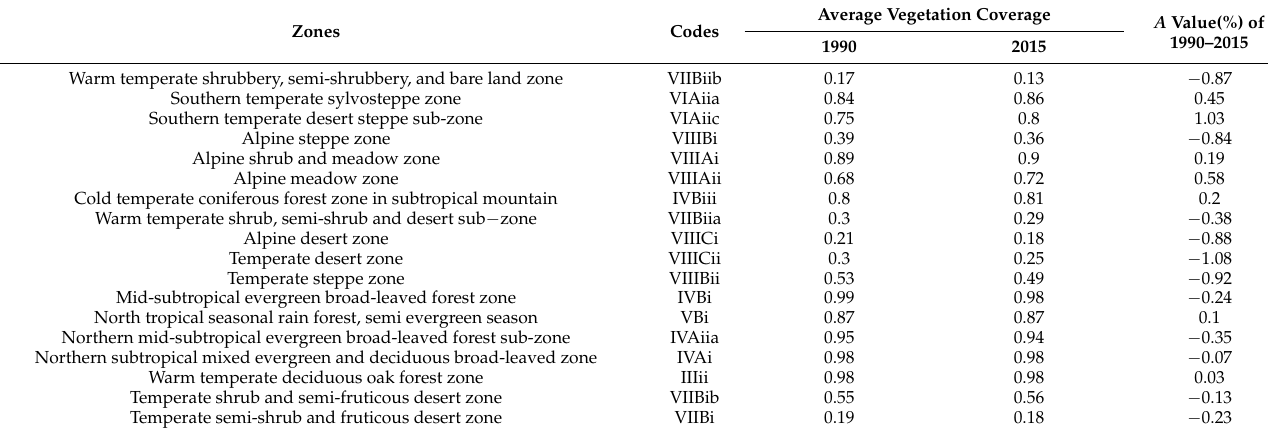
Table 1. Characteristics of different zones on the Qinghai–Tibet Plateau.